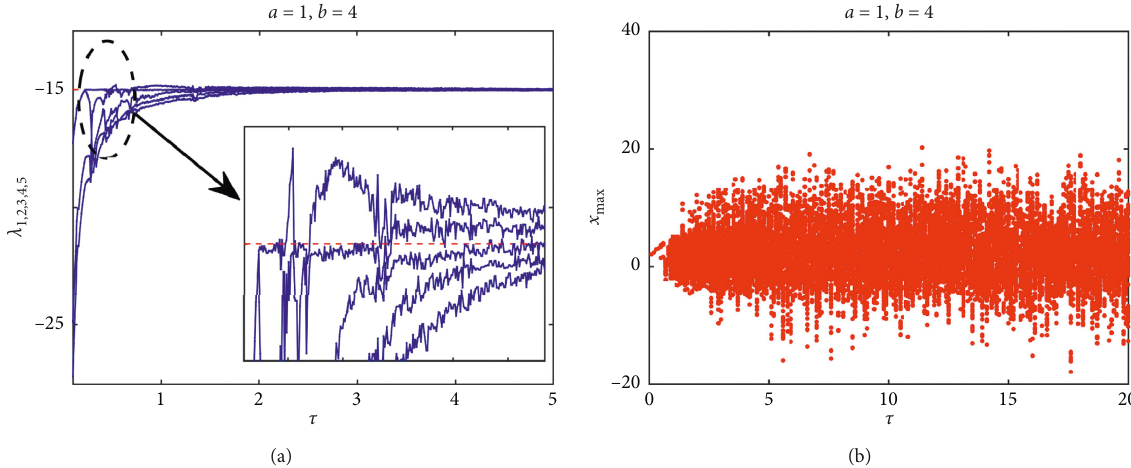
Figure 6: (a) The five largest Lyapunov exponents λ bifurcation diagram for the same parameter as in case